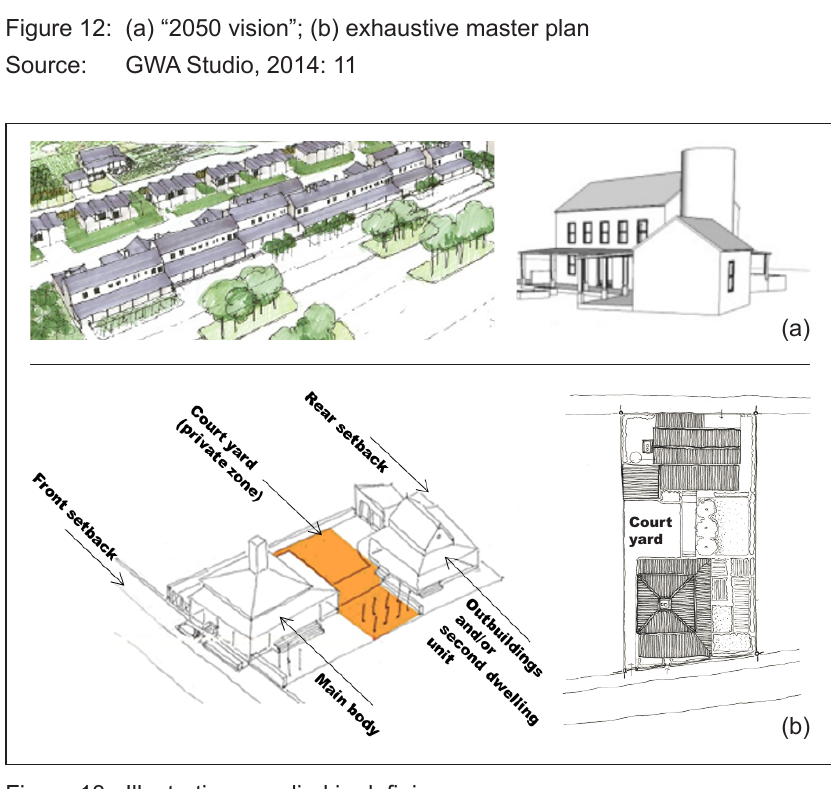
Figure 13: Illustrations applied in defining (a) vertical zoning; (b) the “court